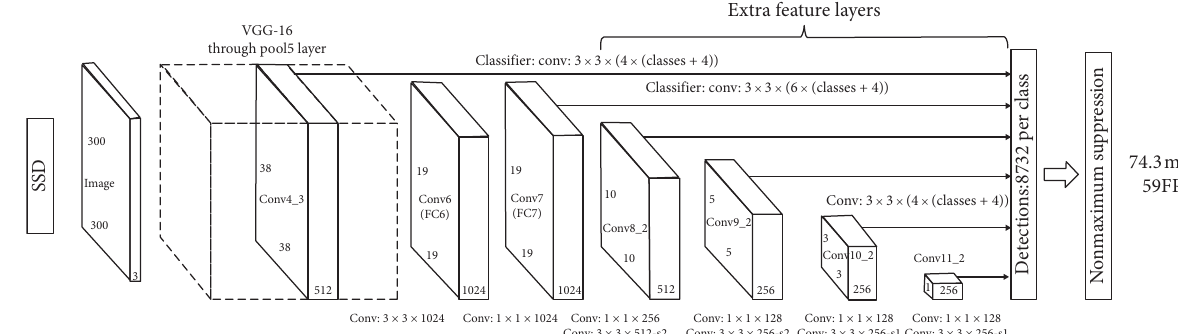
Figure 1: Network architecture of the conventional SSD method by Liu [12]; the VGG-16 is used as the